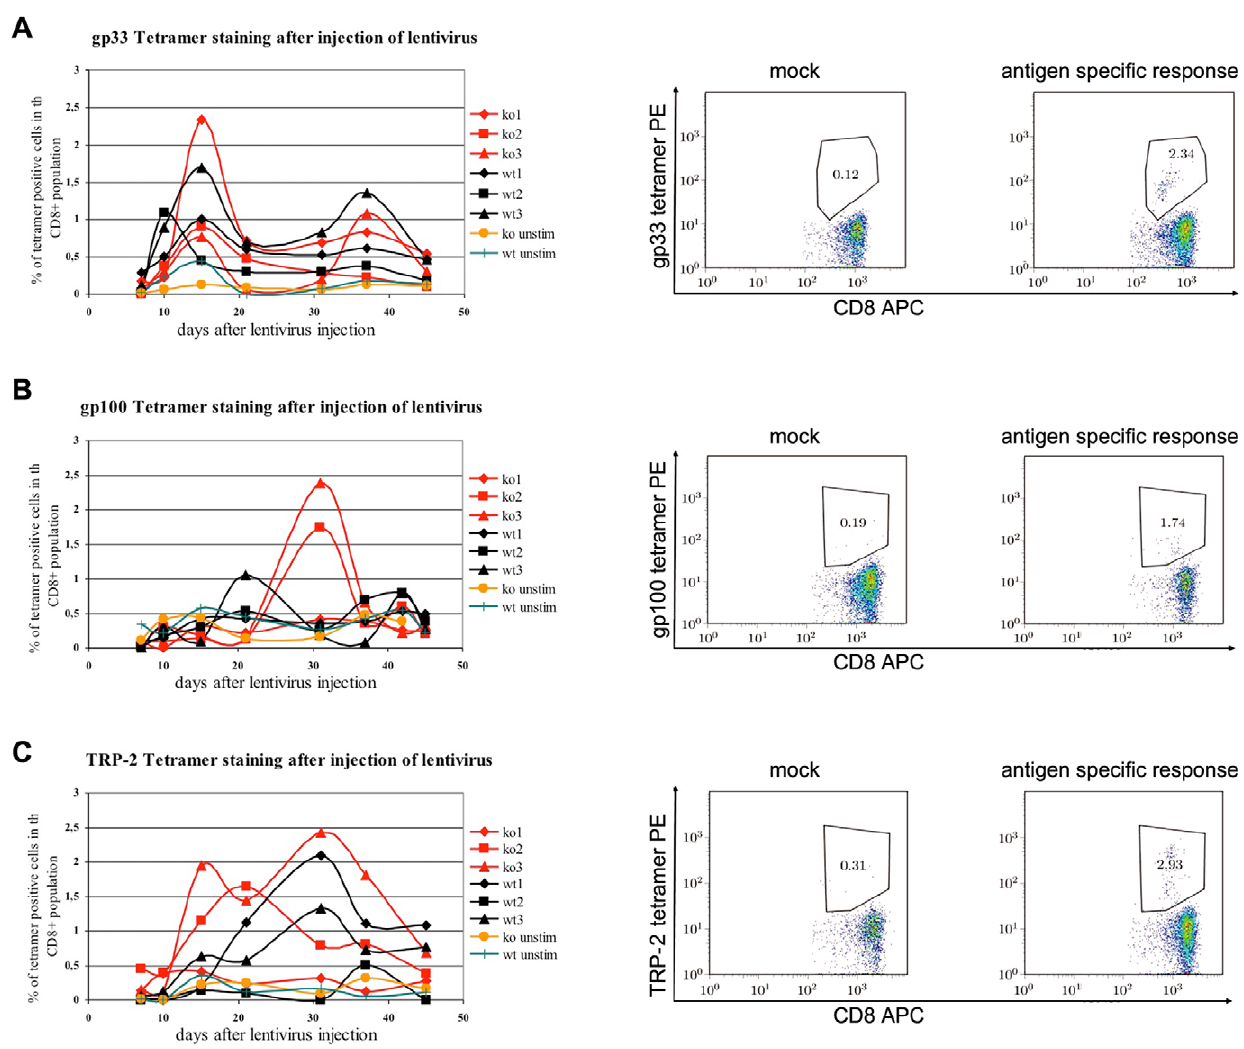
Figure 7. AIRE 2 / 2 mice do not hyperreact to foreign antigen but respond better to certain melanocyte antigen than AIRE + / + littermate controls. Mice of the indicated genotype were injected s.c at the base of the tail with 4 6 10 6 pfu of lentivirus expressing the indicated peptides. Serial samples of blood cells (left panels) were stained for CD8 and MHC class I tetramers specific for T cells responding to the injected peptides (example at peak of response in right panels). A LCMV-derived foreign gp33 presented by H-2D b B mouse TRP-2 presented by H-2K b C gp100 presented by H-2D b .